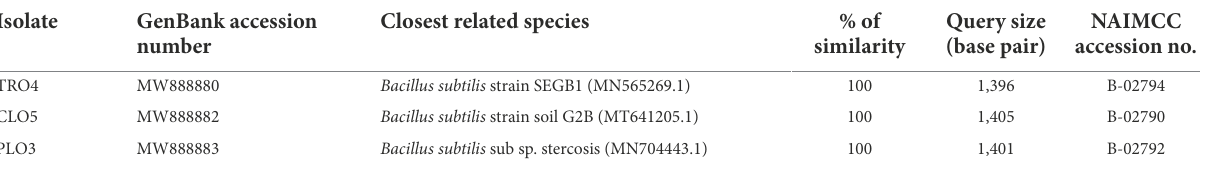
TABLE 3 Molecular characterization of the selected bacterial endophytes based on 16s rRNA gene sequence analysis. Isolate